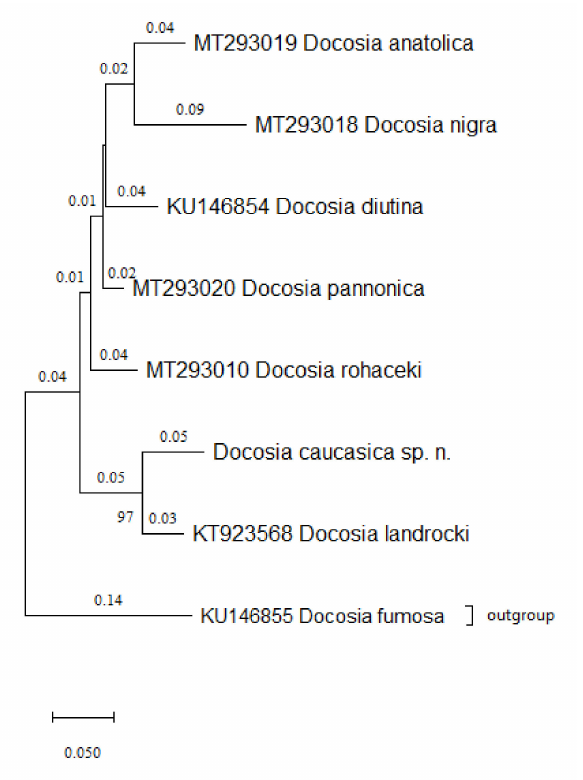
Figure 4. Maximum likelihood hypothesis for the relationships between a group of Docosia spp., constructed by using the General Time Reversible model [24]. A discrete Gamma distribution was used to model evolutionary rate differences among sites (5 categories (+G, parameter = 0.2193)), and the tree is drawn to